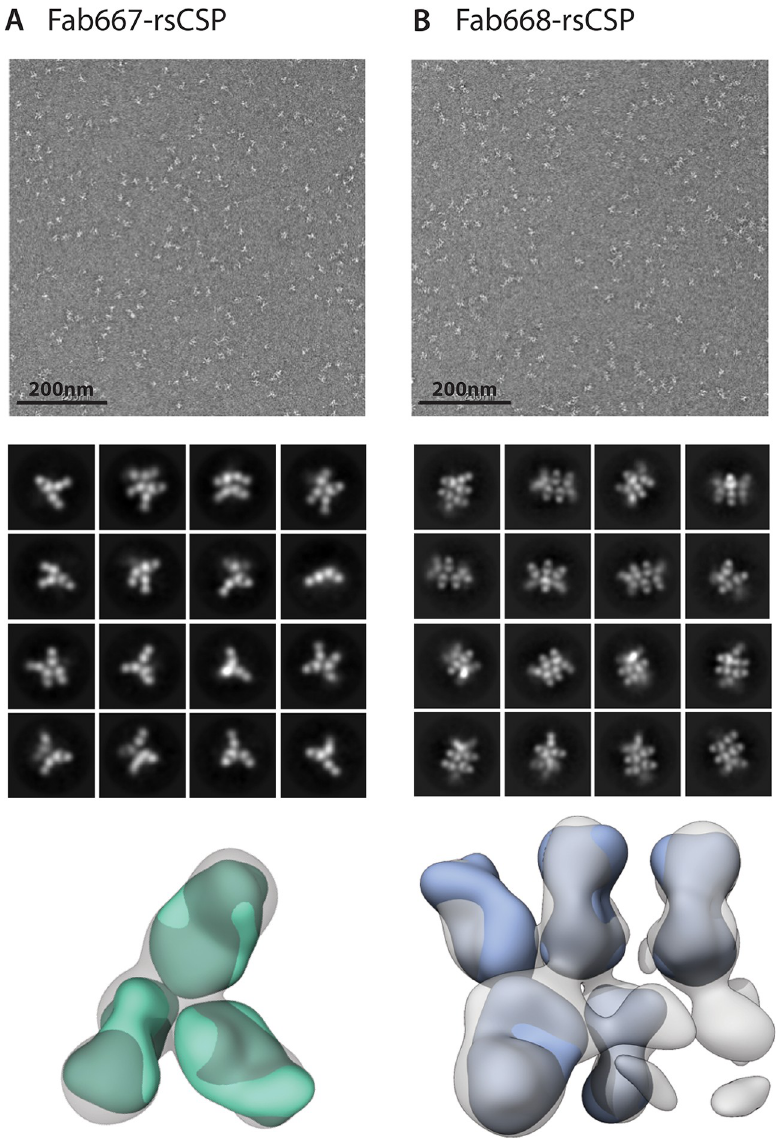
Fig 4. Negative-stain electron microscopy of rsCSP complexes. nsEM was used to assess the stoichiometry of the Fab667 and Fab668 complexes to rsCSP. 2D class averages and 3D reconstructions are shown for ( A ) Fab667-rsCSP and ( B ) Fab668-rsCSP complexes. Fab667-peptide (green) and Fab668 (cyan) were docked into their respective nsEM maps. The class averages and the 3D reconstructions both exhibit a lower apparent stoichiometry of Fabs bound in the Fab667 complex compared to the Fab668